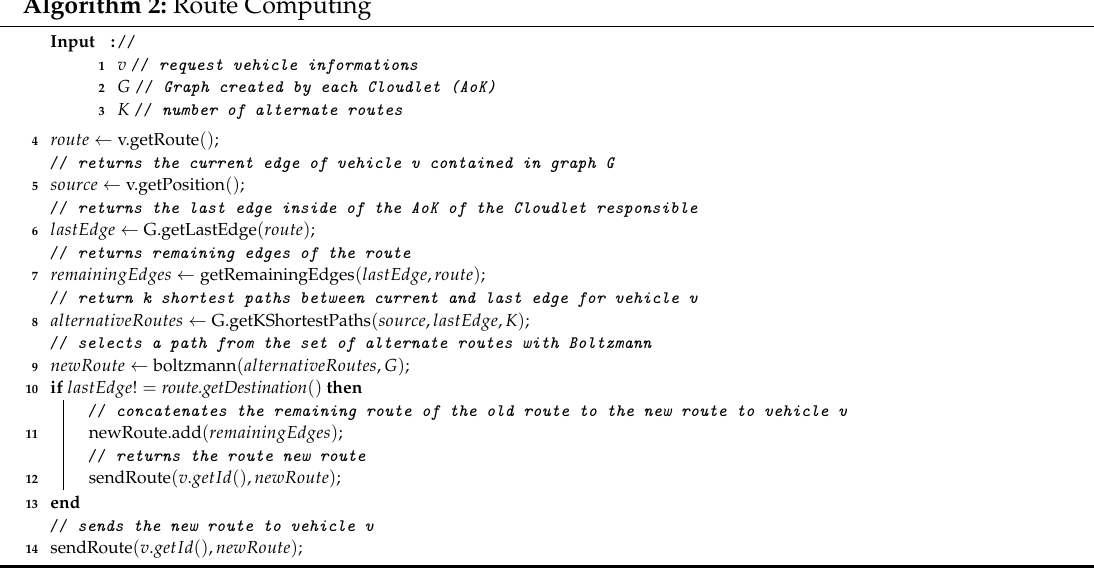
Algorithm 2: Route